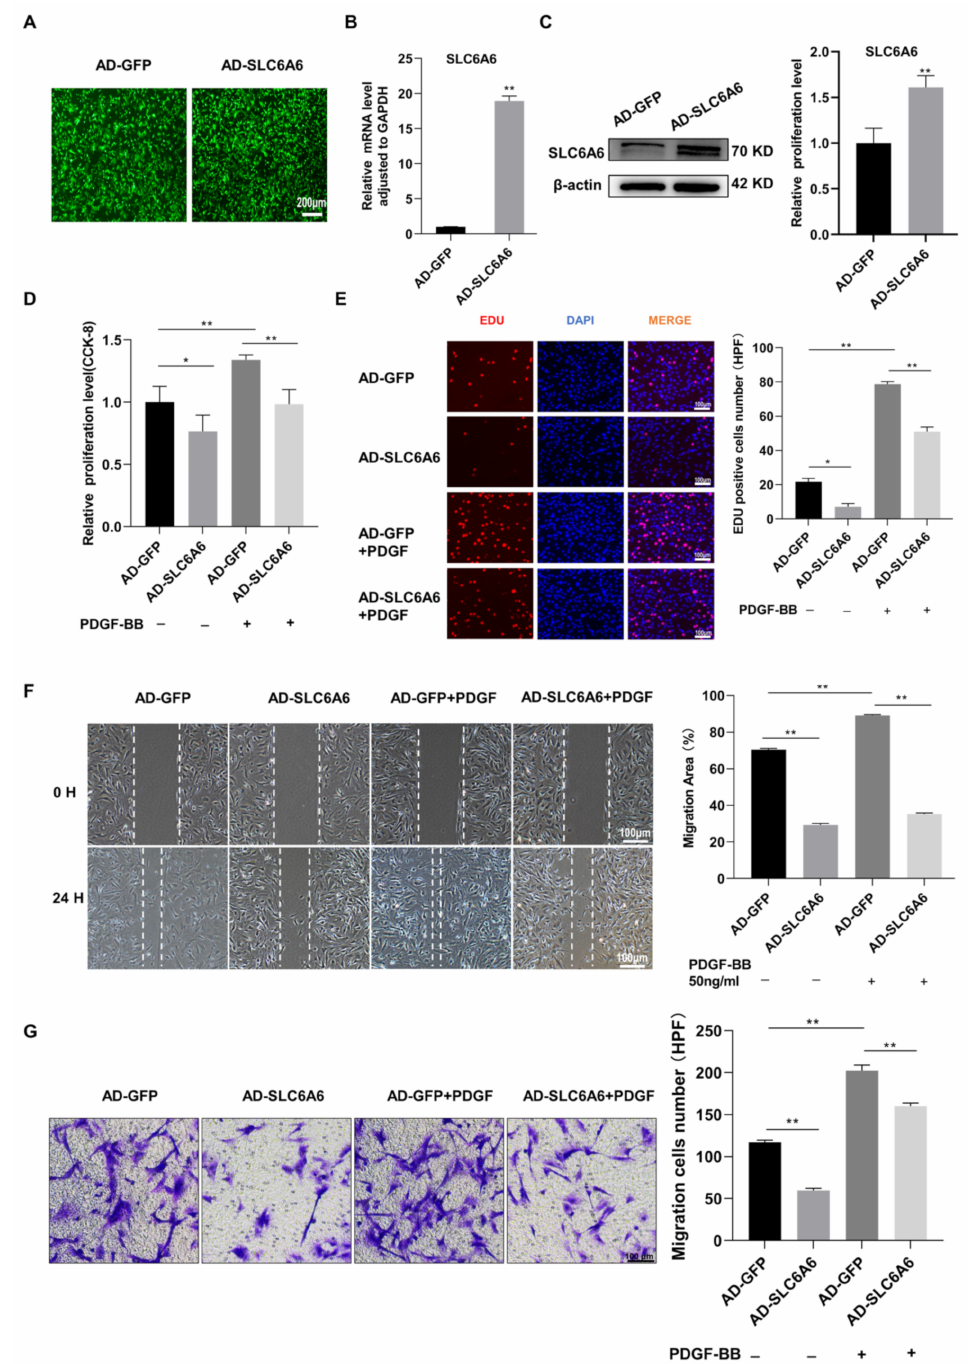
Figure 5. SLC6A6 overexpression reduced PDGF‑BB‑induced VSMC proliferation and migration. ( A ) Efficiency of adenovirus infection in VSMCs was observed under fluorescence microscope. Scale bar: 200 µ m (200 × ). ( B ) qRT‑PCR and ( C ) Western blot analyses showing SLC6A6 mRNA and pro‑ tein levels after infecting VSMCs with AD‑GFP or AD‑SLC6A6; N = 3; * p < 0.05, ** p < 0.01 vs. AD‑ GFP. Data are represented as mean ± SD. ( D ) CCK‑8 assays and ( E ) EdU assays showing VSMC proliferation after overexpressing SLC6A6 for 24 h with or without PDGF‑BB (50 ng/mL) for another 24 h, respectively. Scale bar: 100 µ m (200 × ). N = 3; * p < 0.05, ** p < 0.01. Data are represented as mean ± SD. ( F , G ) Wound‑healing and Transwell assays showing VSMC migration after overex‑ pressing SLC6A6 for 24 h with or without PDGF‑BB (50 ng/mL) for another 24 h. Scale bar: 100 µ m (100 × ). HPF, high power field. N = 3; * p < 0.05, ** p < 0.01. Data are represented as mean ±